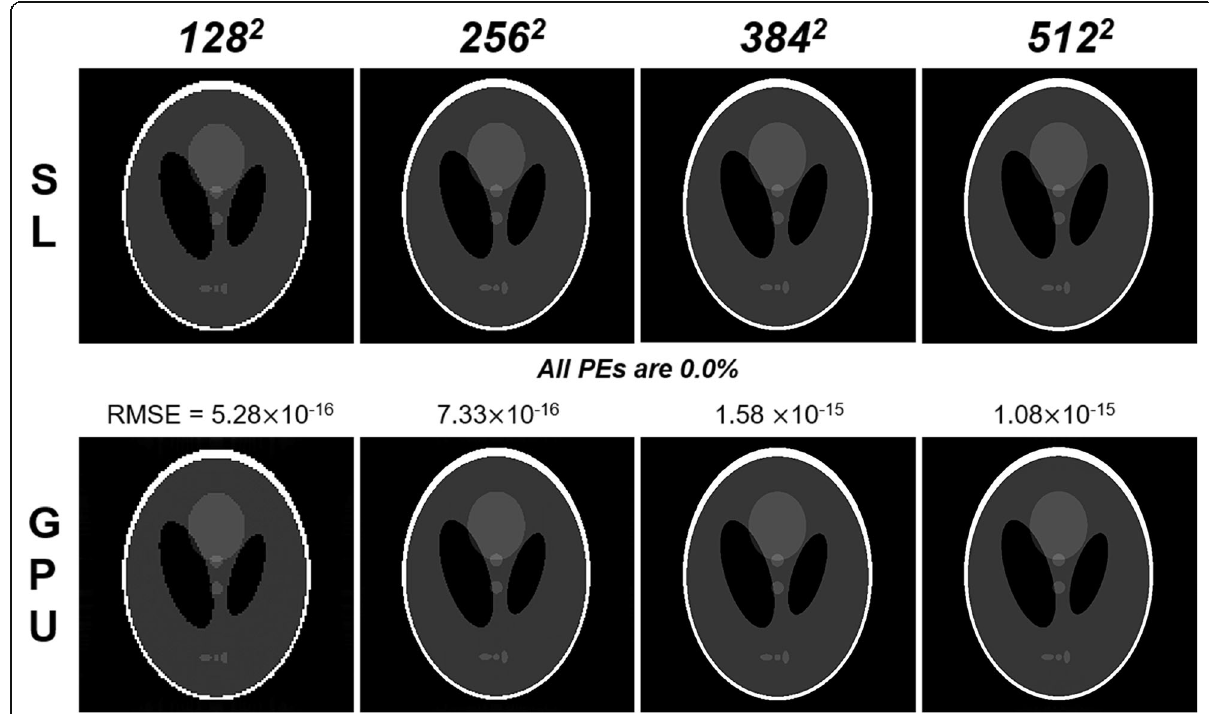
Fig. 4 Performance evaluation of the GPU-based implementation of the sinc function. The difference between the results and the Shepp – Logan phantom (SL) images is hardly visible. The GPU-implemented fast sinc function obtains no reconstruction errors. RMSE, root-mean-squared error; PE, percent